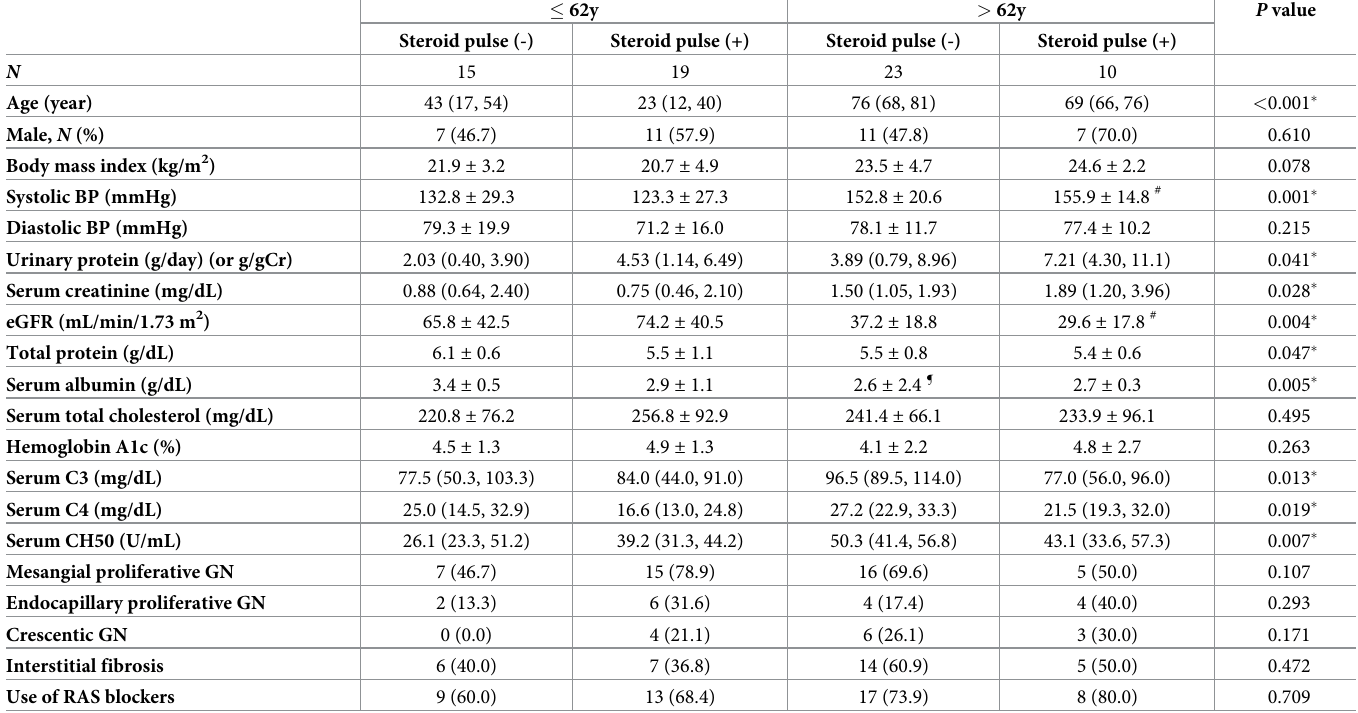
Table 3. Clinicopathological findings at baseline in patients with IC-MPGN stratified by median age (62 y) and with or without steroid pulse therapy at initial treatment. � 62y > 62y Steroid pulse (-)